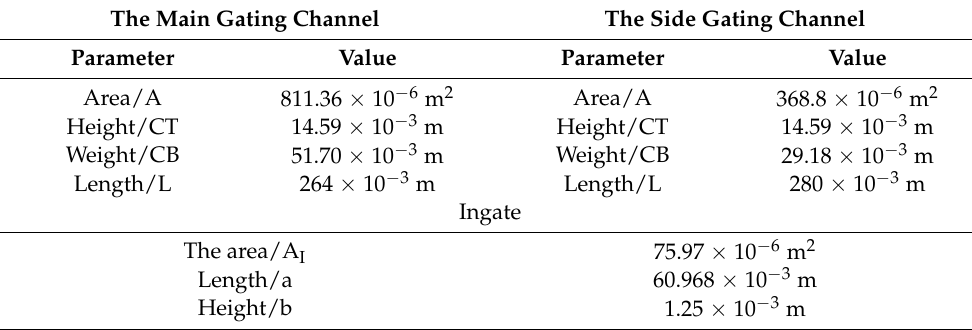
Table 5. Dimension of the gating